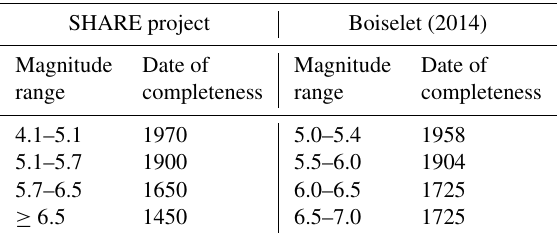
Table 4. Completeness hypothesis explored in this